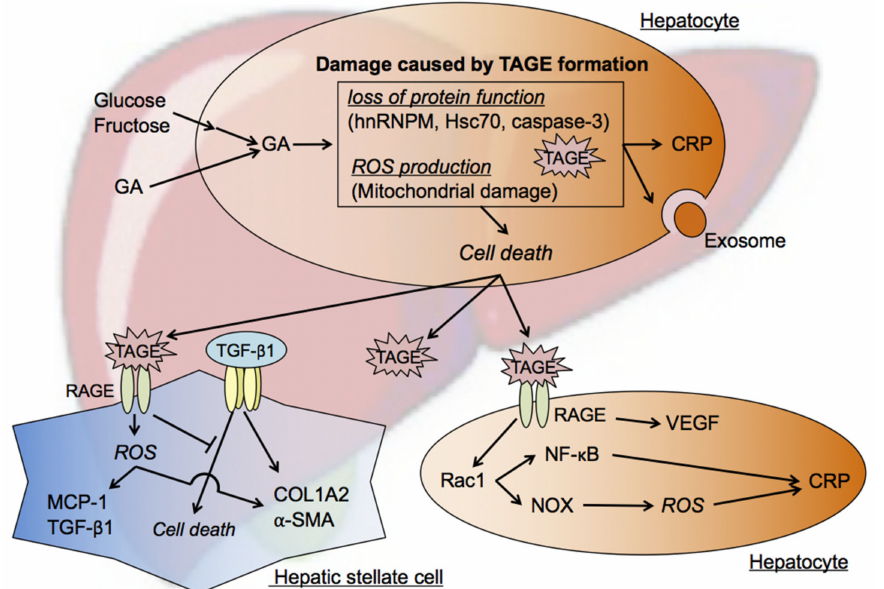
Figure 4. TAGE cytotoxicity against hepatocytes and hepatic stellate cells (HSC). The chronic intake of excessive amounts of sugar-sweetened beverages and processed food products increases the concentration of the sugar metabolite GA in hepatocytes. GA accumulation in these cells promotes TAGE modifications in cellular components. Loss of protein function and mitochondrial membrane abnormalities are associated with the formation of TAGE. ROS are also produced intracellularly and ultimately cause hepatocyte death. Hepatocyte death may cause TAGE-modified proteins to leak from cells, and extracellular TAGE affect the surrounding cells via the TAGE-RAGE axis. The TAGE- RAGE axis exerts inflammatory effects within hepatocytes. HSC are also affected by extracellular TAGE. ROS production and fibrosis are promoted in HSC through the activation of TAGE-RAGE signaling. In addition, TAGE inhibit TGF- β 1-induced cell death and help to maintain the number of HSC, resulting in increased extracellular matrix molecule production and, ultimately,